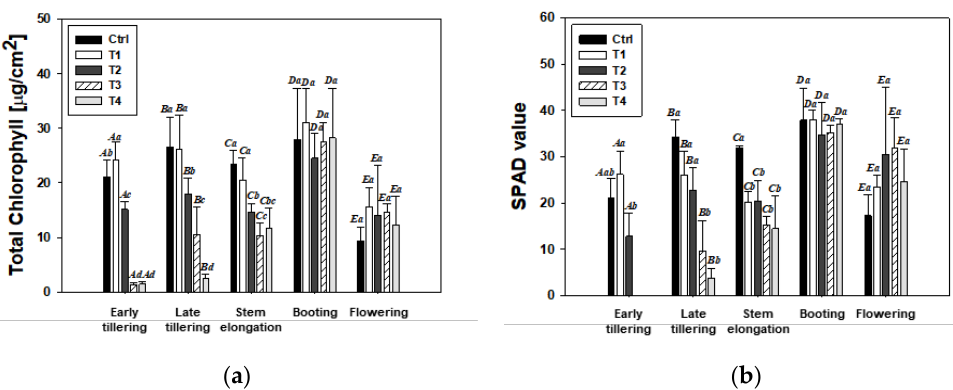
Figure 8. Leaf chlorophyll content-based damage assessment of rice after toluene exposure: ( a ) leaf chlorophyll content measured by photometric method; ( b ) SPAD value measured by chlorophyll meter. The same capital letters refer to the same growth stages. The small letter refers to the significant difference in leaf chlorophyll content among the control group and toluene exposed rice (α = 0.05).